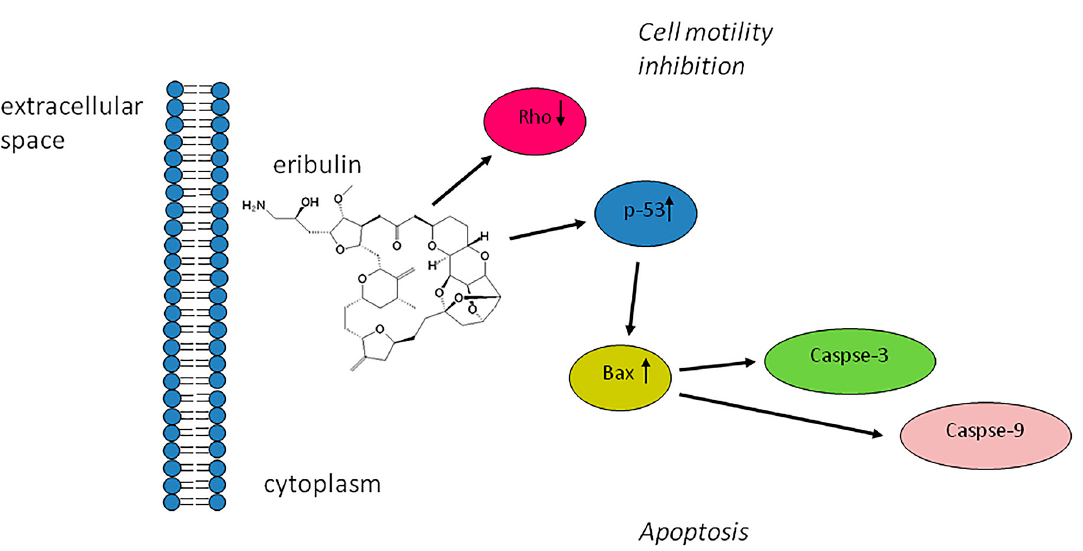
Figure 4. Possible mechanism of the cytotoxic effect mediated by eribulin in ALT and DDLPS patient-derived primary culture.